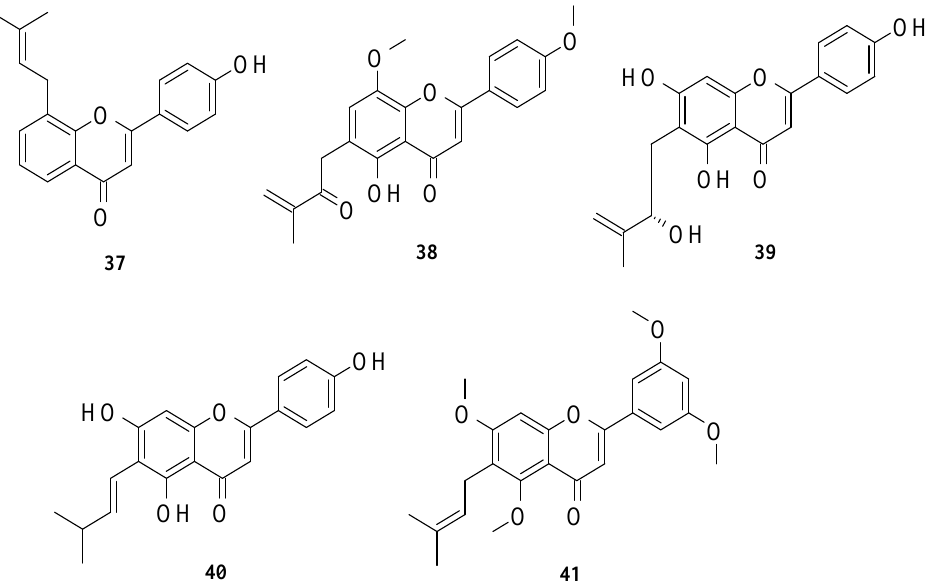
Figure 9. Chemical structure of isolated flavonoids from A. heterophyllus [39]. Zhang et al. investigated the inhibition of IL-8 released by lipopolysaccharide-stimulated bronchial epithelial cells by 17 flavonoids [40]. It was found that apigenin ( 17c ) and luteolin ( 5 ) exerted the most significant inhibition compared to other flavonoids. Both compounds contained hydroxyl groups at the C5 and C7 positions of the A-ring, the C2–C3 double bond, and oxygenation at C4 of C-ring. Therefore, it can be said that these structural features are important in the inhibitory activity. It was also discovered that chalcones with a broken C-ring, such as phloretin ( 8 ), exhibited equal efficacy to 17c , indicating that the co-planar structure was not required or essential for inhibition. Pelargonidin ( 42 ), on the other hand, demonstrated poorer inhibition than 17c and 8 in the absence of a C2–C3 double bond but with a closed C-ring, indicating that the C2–C3 double bond is a significant structural characteristic. Flavans, (+)-catechin ( 9 ), and ( − )-epicatechin ( 10 ) with no C2–C3 double bond also had lower activity. After that, daidzein ( 33 ) and genistein ( 3 ) with the absence of hydroxyl groups at the C5 and C7 positions, respectively, had weak inhibition of LPS-induced IL-8 release. Therefore, the findings support the statement that the hydroxyl groups at the C5 and C7 positions of the A-ring are important for inhibitory action. Next, the authors mentioned that the hydroxyl group at the C3 position of the C-ring, as can be seen in naringenin ( 18 ), can improve inhibitory action. Ueda et al. evaluated the inhibition of flavonoids against TNF- α production and discussed the related structural features that are responsible for inhibition [41]. For an in vitro study, it was found that apigenin ( 17c ), luteolin ( 5 ), quercetin ( 1 ), and myricetin ( 12 ) inhibited LPS-induced TNF- α that had been produced from a macrophage. Therefore, the authors hypothesized that the presence of hydroxyl groups at the C5 and C7 positions of the A-ring, as well as at the C4′ position of the B -ring, seemed to be important features. Moreover, galangin ( 35 ) and chrysin ( 17a ) exhibited weaker and an absence of inhibitory activities, respectively, when compared. Therefore, it can be suggested that an absence of the hydroxyl group at C4′ of the B-ring can reverse or reduce the bioactivity. Following that, for in vivo assay, the tested flavonoids were orally supplied to mice. It was reported that 5 and 17c decreased serum TNF- α production after oral administration. The presence of hydroxyl groups at the C4′ (B -ring), C5, and C7 (A-ring) positions seemed to be important for oral inhibition, as both 5 and 17c contained these features. Furthermore, as 5 exhibits stronger inhibition, the hydroxyl group at the C3 ′ position of the B-ring may be responsible for the greater inhibition observed with 5 . Jiang et al. synthesized 19 flavanonols and evaluated their NO inhibitory action in RAW macrophage 264.7 cells, as well as discussed the structural activity relationship